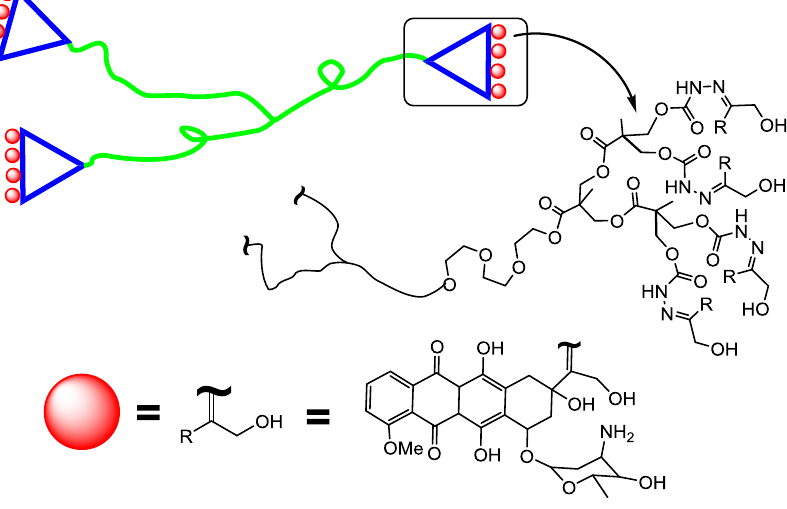
Figure 1. Doxorubicin-functionalized model polyester dendrimer for therapeutic